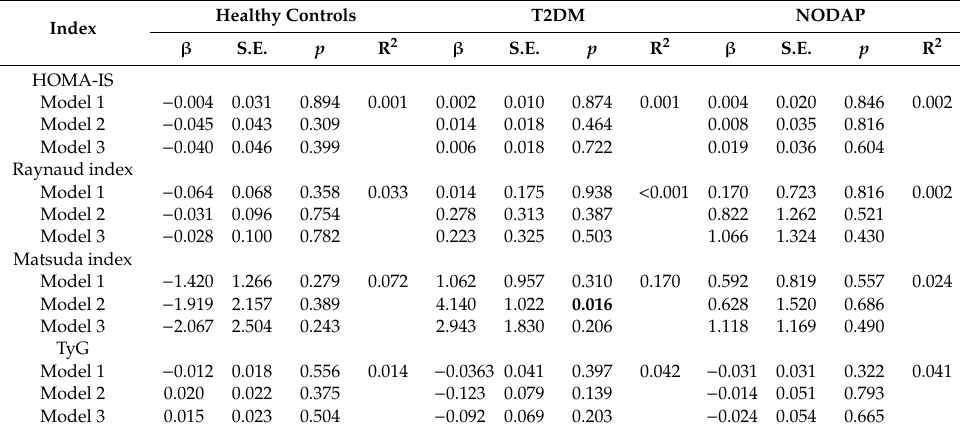
Table 4. Associations between skeletal muscle fat deposition and indices of insulin sensitivity in non-obese